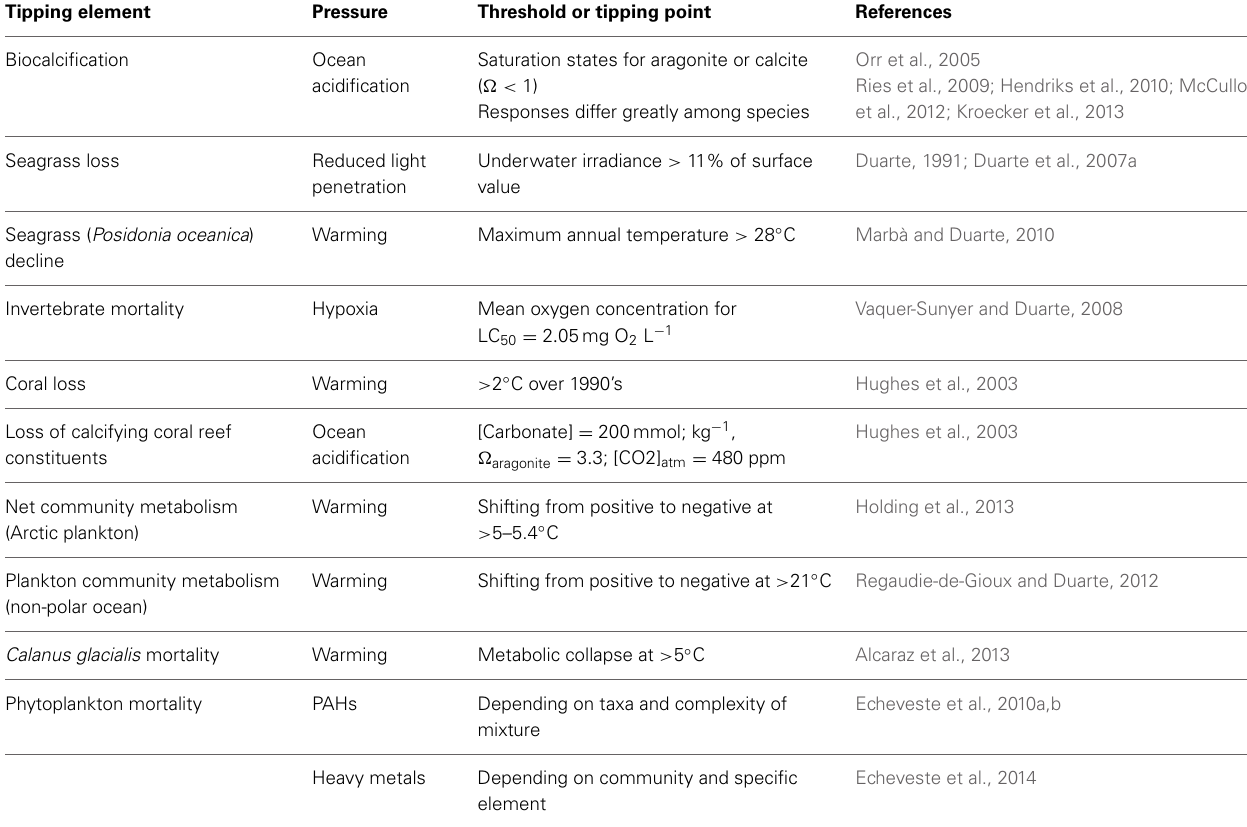
Table 2 | Examples of tipping elements with their corresponding thresholds and tipping points to pressures in the marine